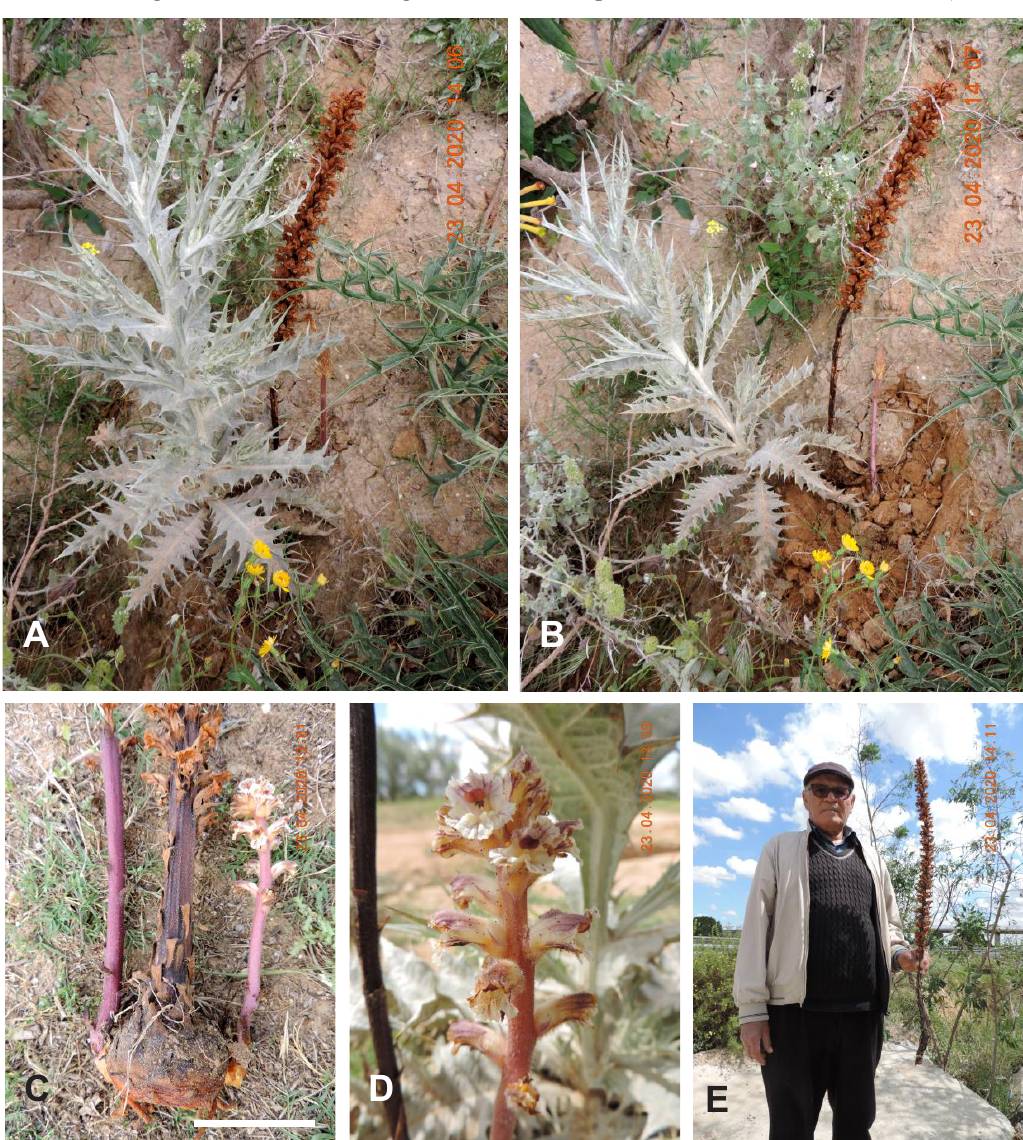
Figure 2. Orobanche dominae El Mokni sp. nov. A-B, Habit on its favorite host species, Onopordum espinae ; C, Stem coarsely bulbous at the base with two juvenile specimens (scale bar = 10 cm); D, Juvenile specimen with lax inflorescence; E, Specimen with length up to 100 cm. Photographed by R. El Mokni (23.04.2020). Orobanche dominae resembles in its calyx length and filament insertion level to Or.